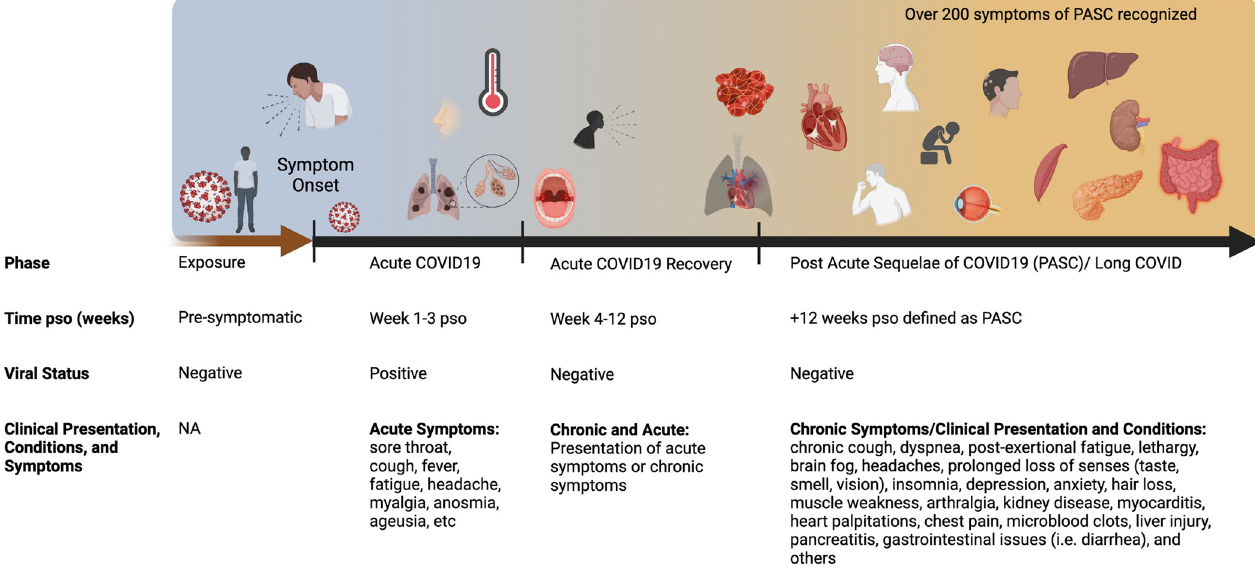
Fig 1. Time course and symptoms of COVID-19 and PASC. AU : AbbreviationlistshavebeencompiledforthoseusedinFigs 1 (cid:0) 2 andTable 1 : Pleaseverifythatallentriesarecorrect : Acute COVID-19 includes symptoms present up to 4 weeks. Live virus is typically present in the respiratory tract for 1-week pso, with variability among individuals. Common symptoms of acute COVID-19 are summarized that include pulmonary and systemic manifestations. Long COVID or PASC includes persistent symptoms present 4 weeks post-acute infection. The diverse range of multiorgan complications of PASC are summarized. COVID-19, Coronavirus Disease 2019; PASC, Post-Acute Sequelae of COVID-19; pso, post-symptom onset.